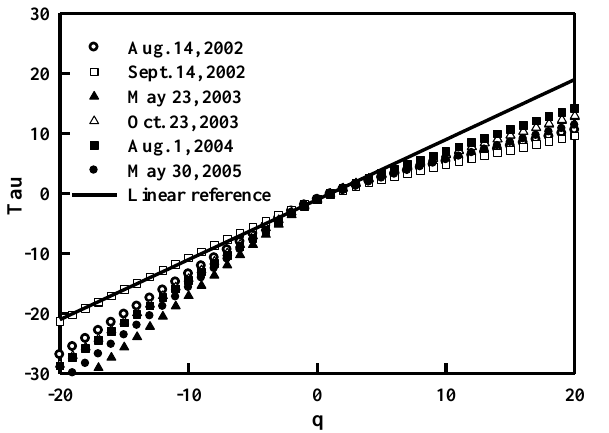
Fig. 5. The multifractal spectra of the water storage series ( q = − 20 to 20 at 1.0